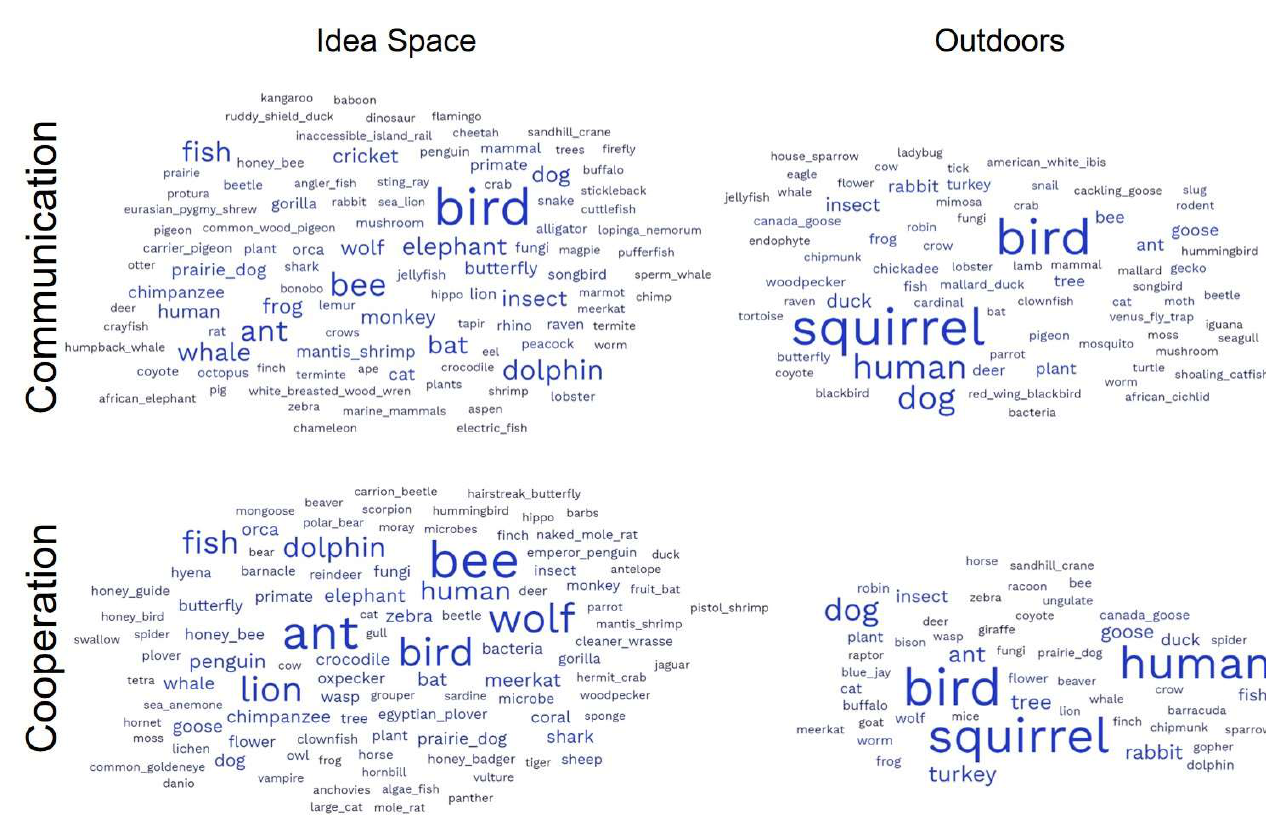
Figure 5. Word clouds generated from student responses and the list of represented taxonomic classes for the “Communication” and “Cooperation” assignments that were completed factorially with the outdoor and idea-space interventions. The idea-space intervention elicited a greater number of examples, a greater diversity of taxonomic classes, and examples that were more specific relative to the outdoor treatment. Raw frequency data can be found in [50] under an open access license.